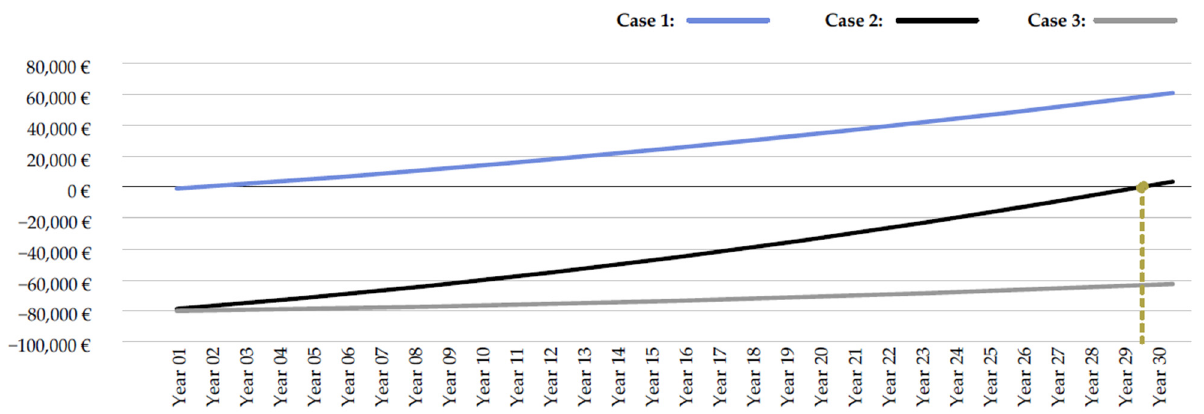
Figure 21. Calculation of the optimal cost of thermochromic paint for the case of Barcelona.